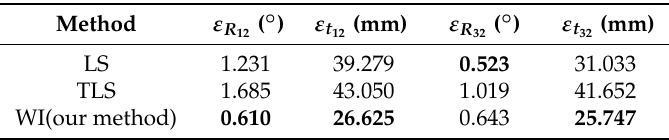
Table 3. The rotation error and translation error of the LRFs’ extrinsic parameters calibrated by LS, TLS, and